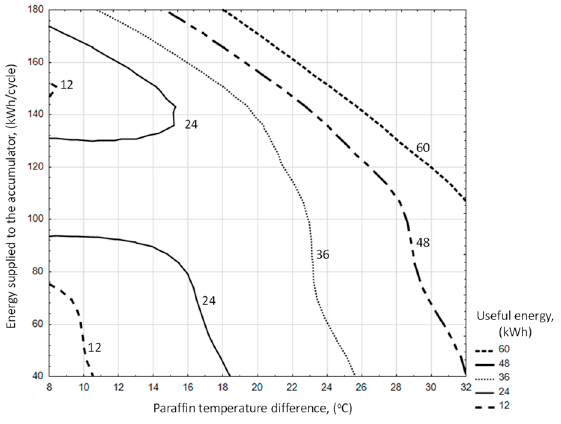
Figure 33. Useful energy in the heat storage process depending on the difference in paraffin temperature and energy supplied to the PCM accumulator.